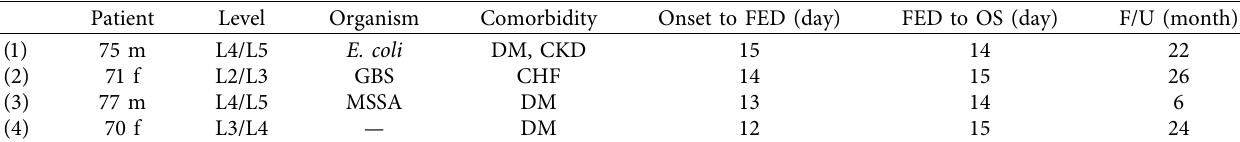
Table 2: Summary of data in four patients.